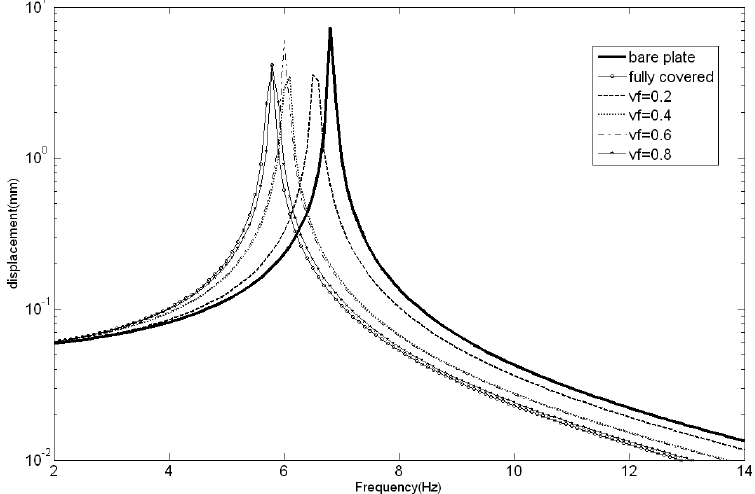
Fig. 14. The first natural